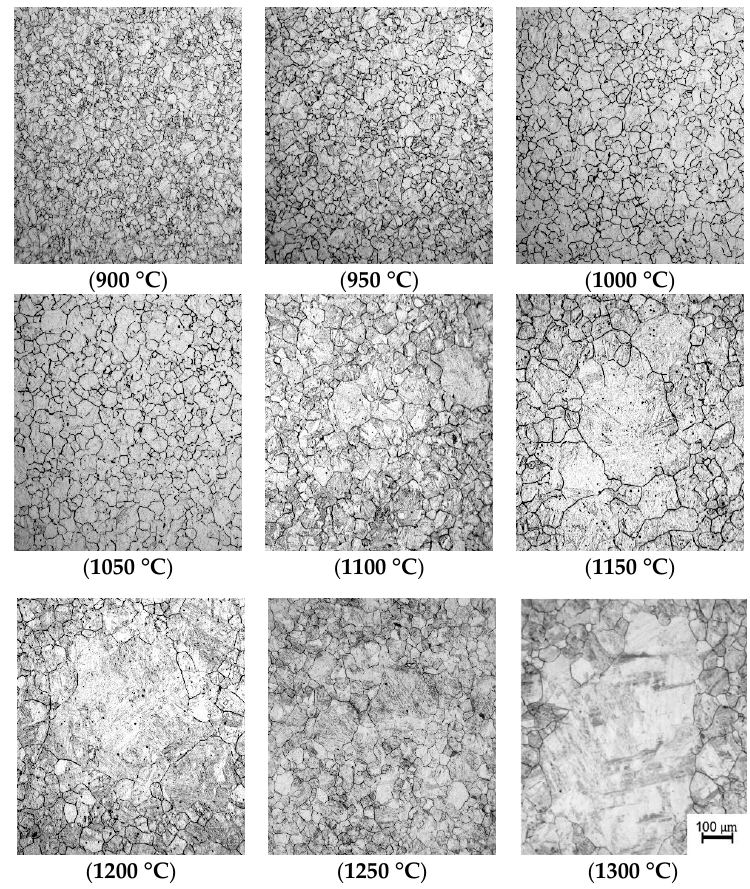
Figure 12. Light optical micrographs of prior austenite grains for steel L8 after soaking to the temperatures indicated.